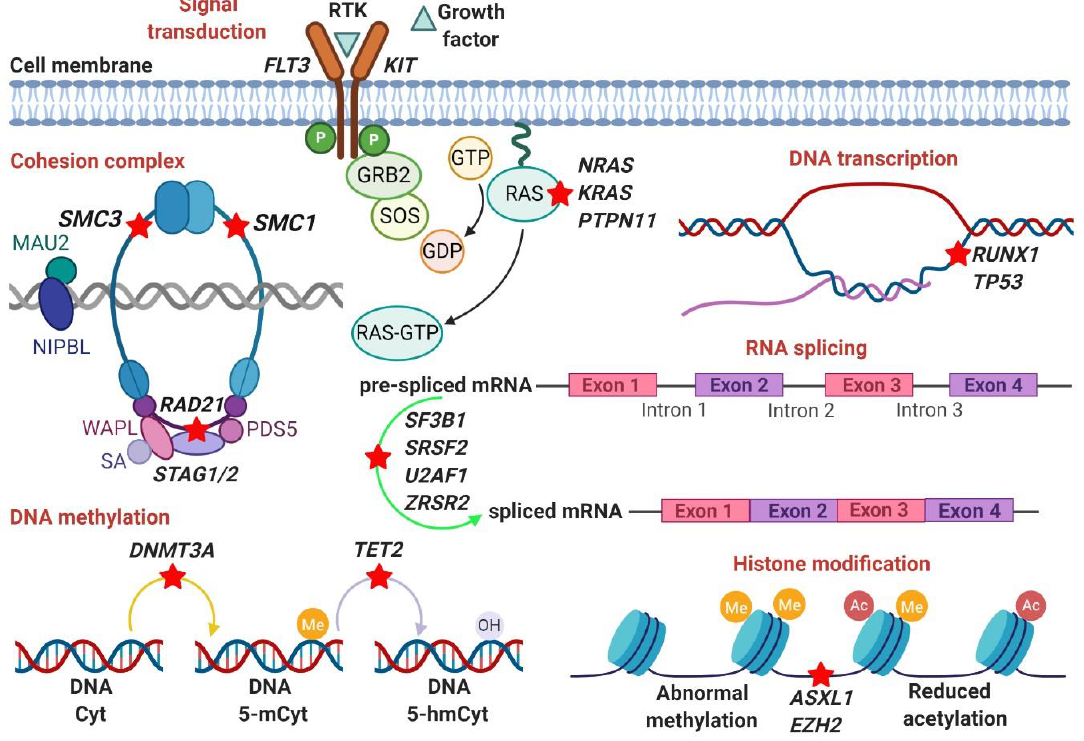
Figure 1. The altered genetic pathways in MDS. The figures illustrate the main genetic pathways involved in the pathogenesis of MDS including: Signal transduction ( KIT , FLT3 , RTK ), Cohesion complex ( RAD21, SMC1/3, STAG1/2 ), DNA transcription ( TP53, RUNX1 ), RNA-splicing ( SF3B1 , SRSF2 , U2AF1 , ZRSR2 ), DNA methylation ( DNMT3A , TET2 ), Histone modification ( ASXL1 , EZH2 ).